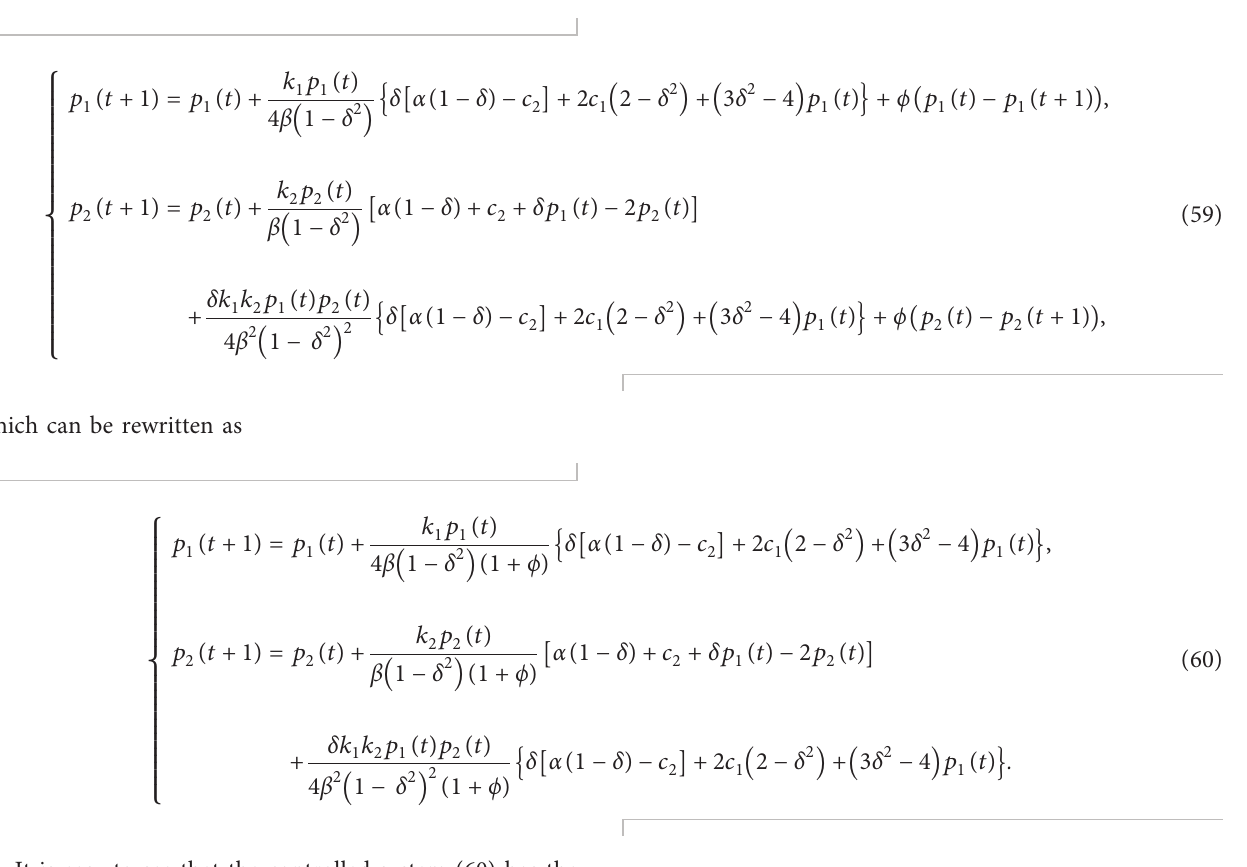
and the profit of IC 1